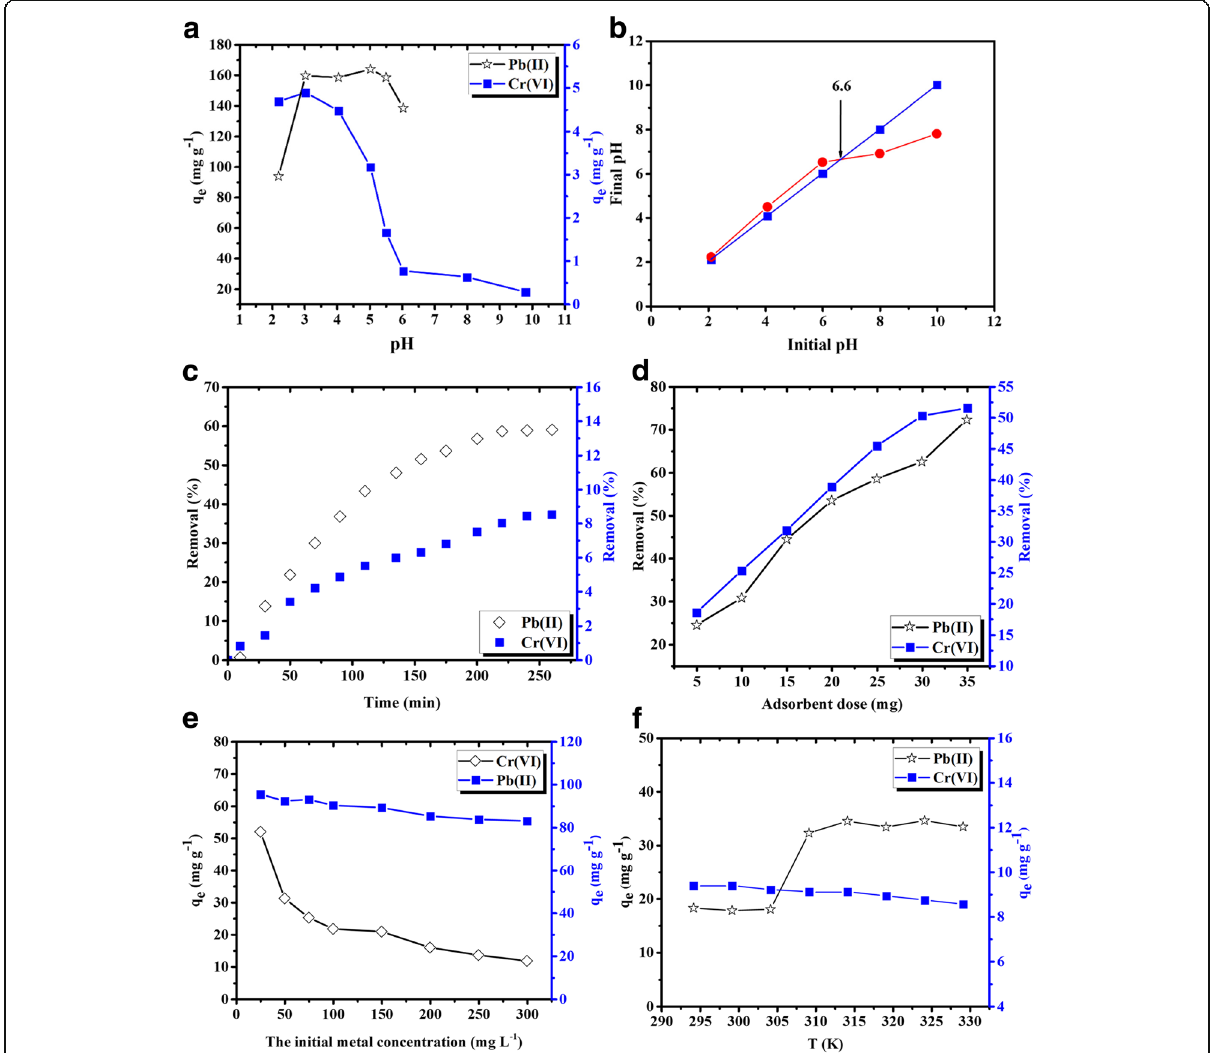
Fig. 6 a Effect of the initial pH [initial concentration of Pb(II) and Cr(VI): 100 mg L − 1 ; adsorbent dose: 0.06 g; T = 25 °C; contact time: 135 min], b point of zero charge, c contact time [initial concentration of Pb(II) and Cr(VI): 100 mg L − 1 ; adsorbent dose: 0.06 g; T = 25 °C; initial pH for Pb(II) and Cr(VI); 3.0 and 5.2], d adsorbent dose [initial concentration of Pb(II) and Cr(VI): 100 mg L − 1 ; T = 25 °C; initial pH for Pb(II) and Cr(VI); 3.0 and 5.2; contact time: 250 min], e initial metal concentration [T = 25 °C; initial pH for Pb(II) and Cr(VI); 3.0 and 5.2; contact time: 250 min; adsorbent dose: 0.06 g] and f temperature [initial concentration of Pb(II) and Cr(VI): 100 mg L − 1 ; adsorbent dose: 0.06 g; contact time: 135 min; adsorbent dose: 0.06 g] for the adsorption of Pb(II) and Cr(VI) onto CSM/SA hybrid